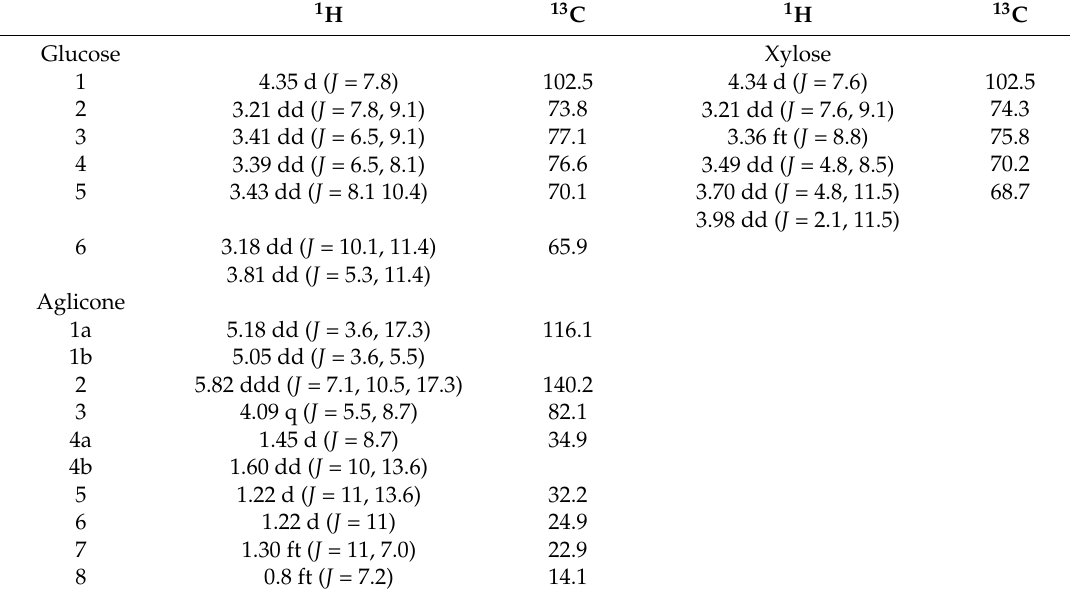
Table 4. 13 C and 1 H-NMR data of 3 a